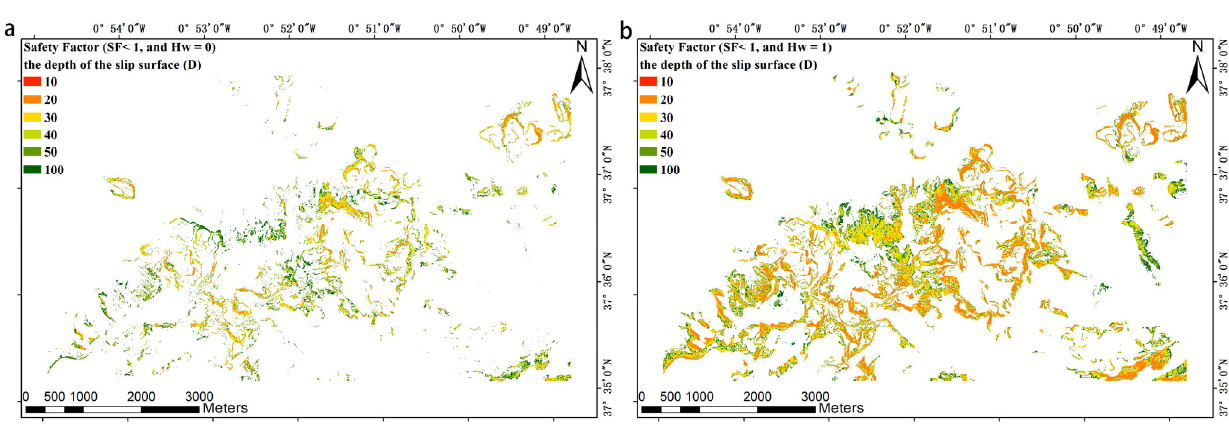
Figure 5. Distribution of areas exhibiting a safety factor lower than 1 in dry conditions (H W = 0) ( a ) and in saturated conditions (H W = 1) ( b ) considering depth values of the slip surface (D) varying from 10 to 100